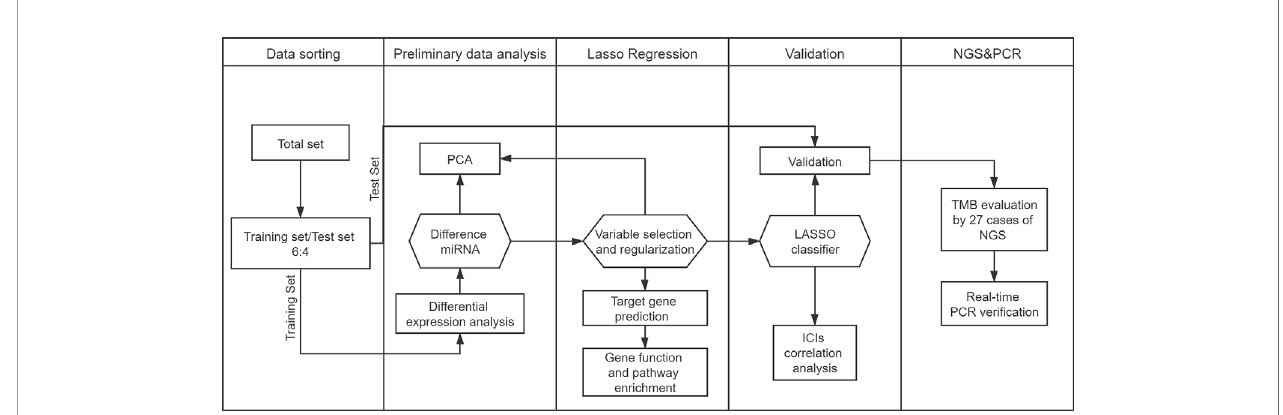
FIGURE 1 | Study work fl